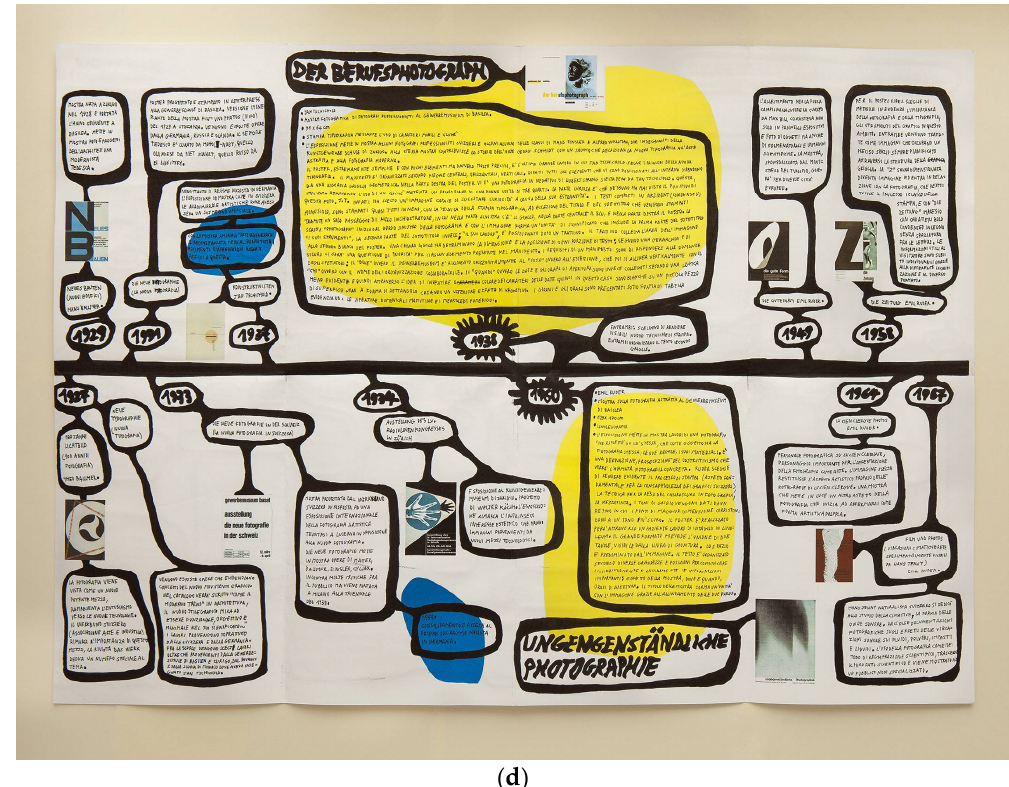
Figure 6. ( a ) Starting with two works by Bruno Munari, a futurist book (1933) and an unreadable book (1964), Debora D’Angelo and Marta Fioravanti have produced a set of cards each presenting and analysing a different kind of “book-object”, using a clear indexing system. A.y. 2015–16. All the students’ projects: photo by Vanja Macovaz; ( b ) Francesca Ballarini and Riccardo Righi used the